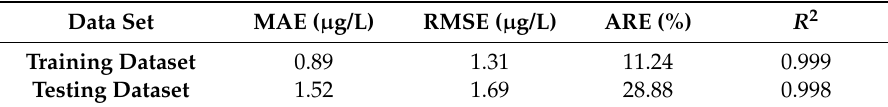
Table 3. The statistical parameters of training dataset and testing dataset.